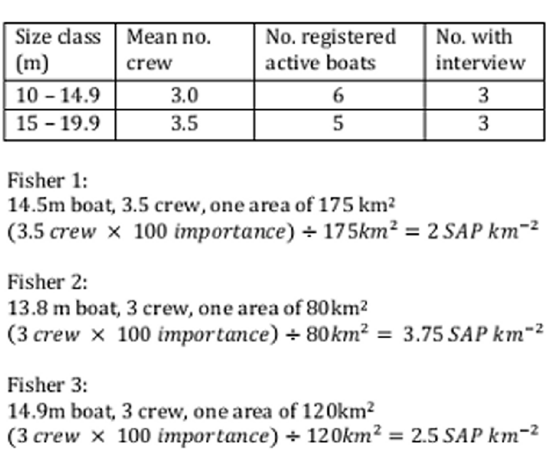
Figure 4. Illustrative example of SAPM using weighting to scale up the sample to represent the population. Illustrative example of SAPM using weighting to scale up the sample (interviewed fishers) to represent the population (whole